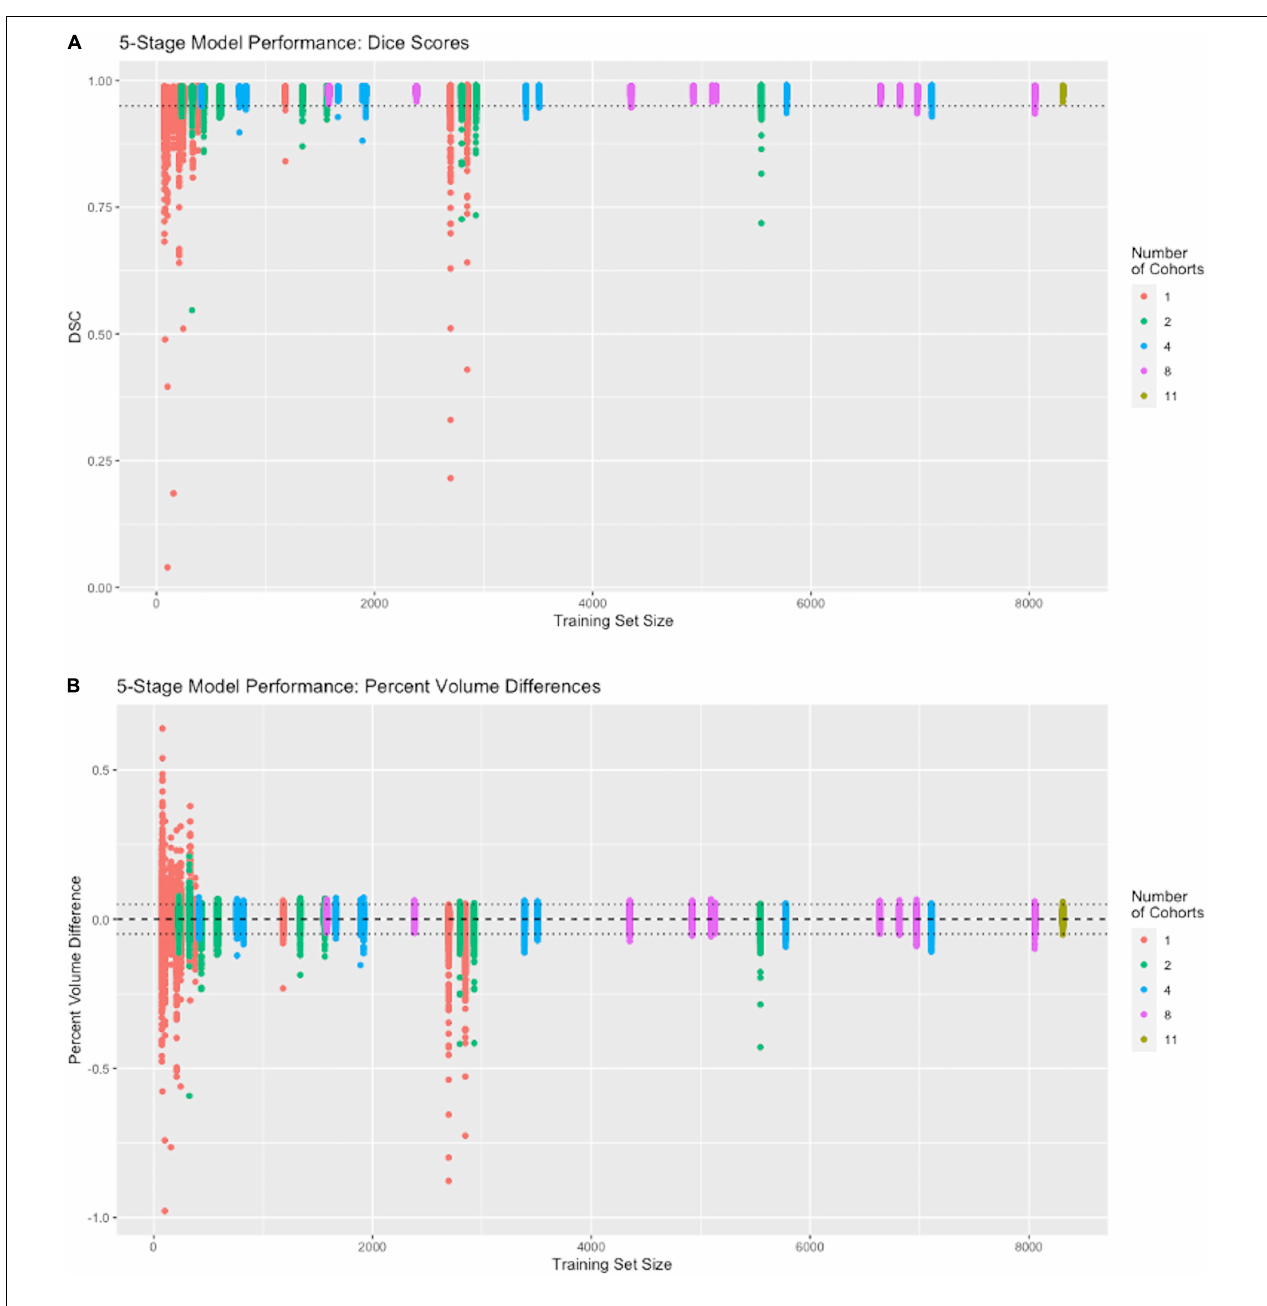
FIGURE 4 | Performance vs. number of cohorts in training. The x -axis shows the number of samples in each individual training session ( N = 74 to 8309). The number of cohorts (1, 2, 4, 8, and 11) in a training set is labeled by color (see legend). Following the protocol in Section “Effects on Performance of Number of Cohorts vs. Raw Dataset Size,” each colored vertical line plots the distribution of DSC matches to 939 test subjects from a CNN model corresponding to one training set. For example, there are 11 red vertical lines, one for each of our 1-cohort trainings, though some are hard to distinguish because of overlap due to similar training set size numbers shown in Table 2 . There is one distribution for the one 11-cohort training. For all others, there are 10 vertical lines of each color. (A) Dice similarity performance against test set ground truth based on training sets of variable cohort diversity. Dotted line indicates DSC = 0.95. (B) Volume difference values (CNN prediction – GT mask volume) as percentage of GT mask volume. Dotted lines indicate ± 0.05, i.e., ± 5